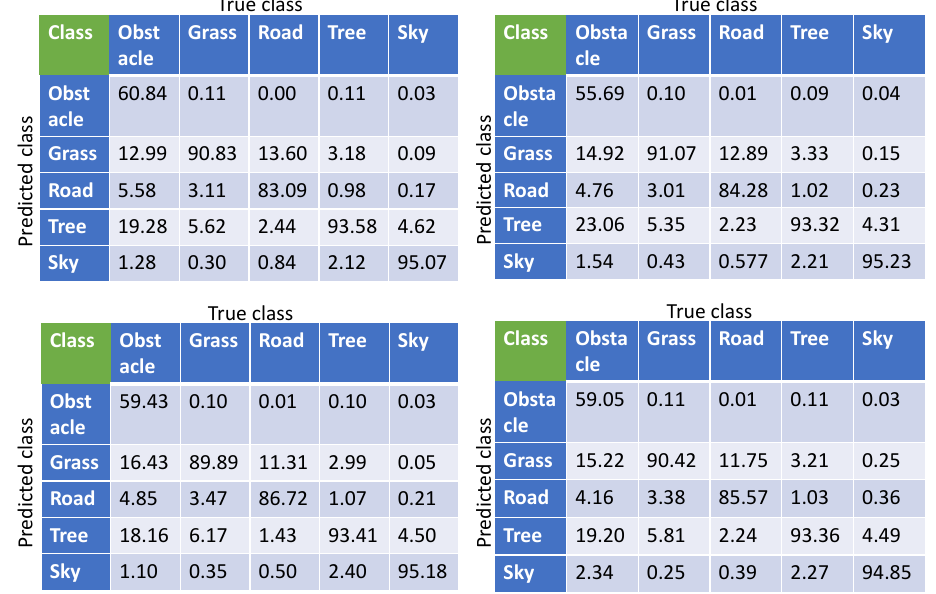
Table 5. Confusion matrices of the test results produced by the proposed network for different TL experiments on the Freiburg Forest dataset. Note that each entry is an overall percentage. (Top left: without using synthetic dataset, top right: using two-class synthetic dataset, bottom left: using four-class high-definition synthetic dataset, bottom right: using four-class random synthetic